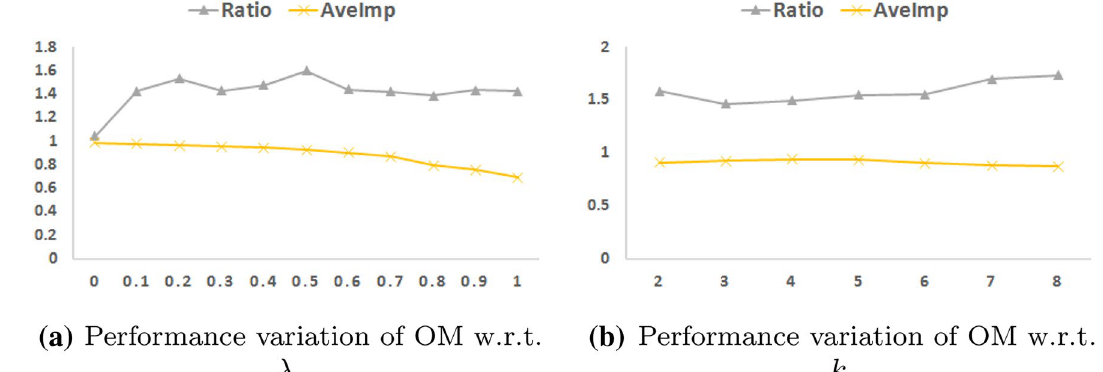
Fig. 3 Parameter tuning